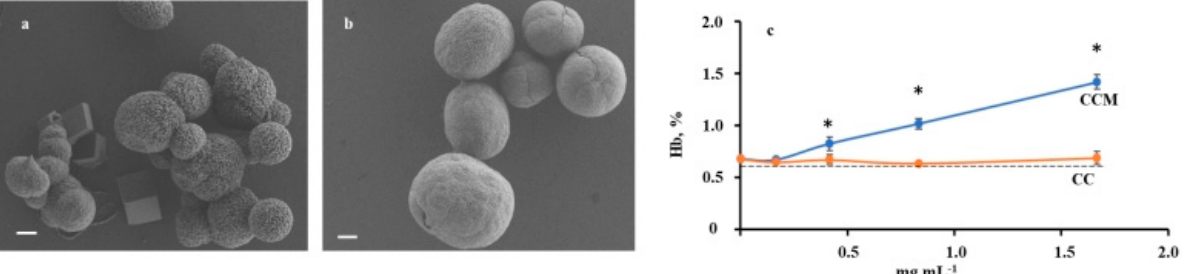
Figure 1. SEM of CC ( a ) and CCM ( b ) microparticles (scale bar 1 µm); effect of CC and CCM concentration on hemolysis assessed by Hb release ( c ). Erythrocytes (0.8 × 10 9 cells mL − 1 ) in 0.15 M NaCl were incubated with microparticles for 2 h at 37 °C. Dotted line corresponds to spontaneous erythrocytes lysis. All measurements were performed in triplicate. * p < 0.001 vs. CC.